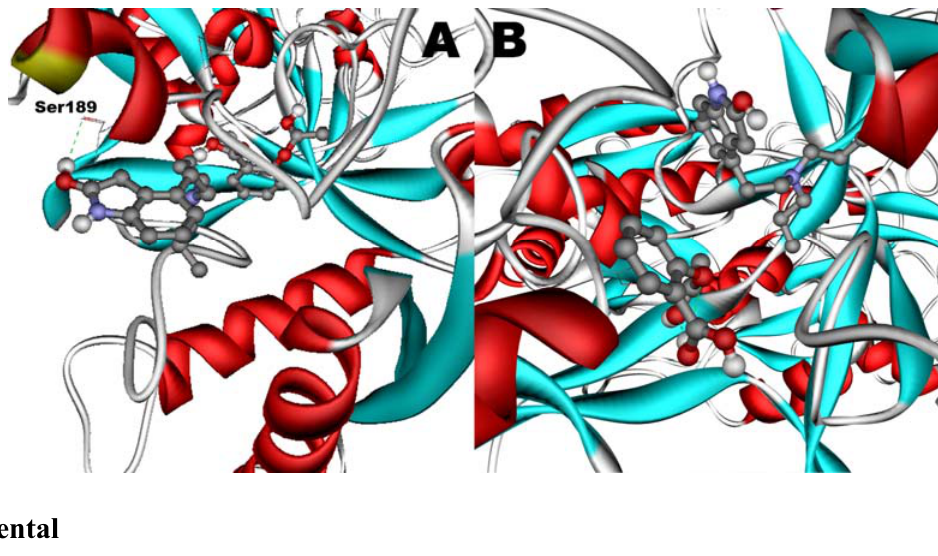
Figure 12. Docking of ASA ( A ) as a third ligand onto the ROP-hTf complex. ROP ( B ) docked onto the ASA-hTf complex. ASA and ROP are shown as balls and sticks. FeCO3, if visible, is shown as sticks. Hydrogen bonds are shown as green dotted